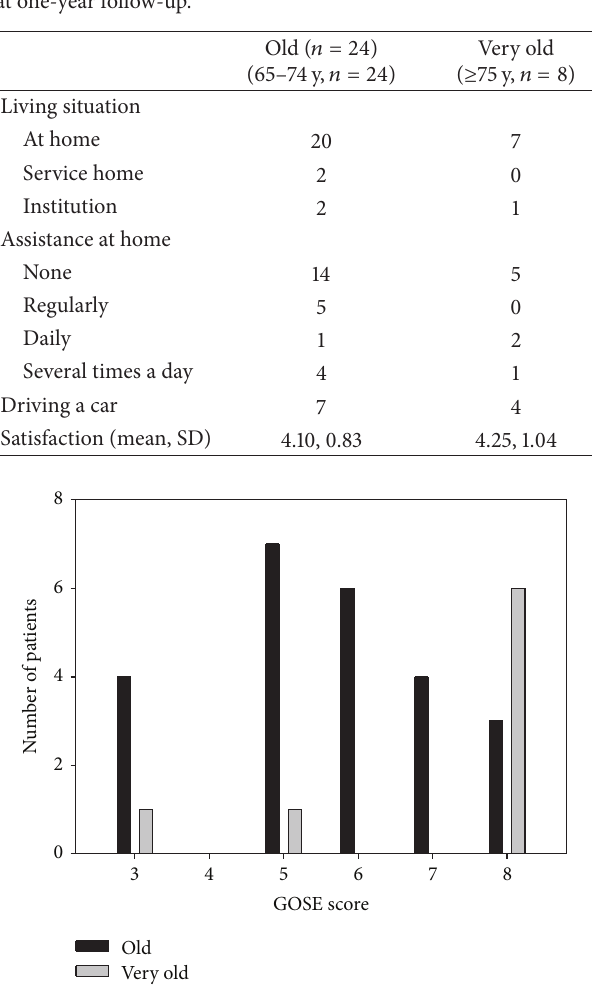
Figure 1: Distribution of GOSE score for the surviving old (black bars) and very old (grey bars) patients at 12-month